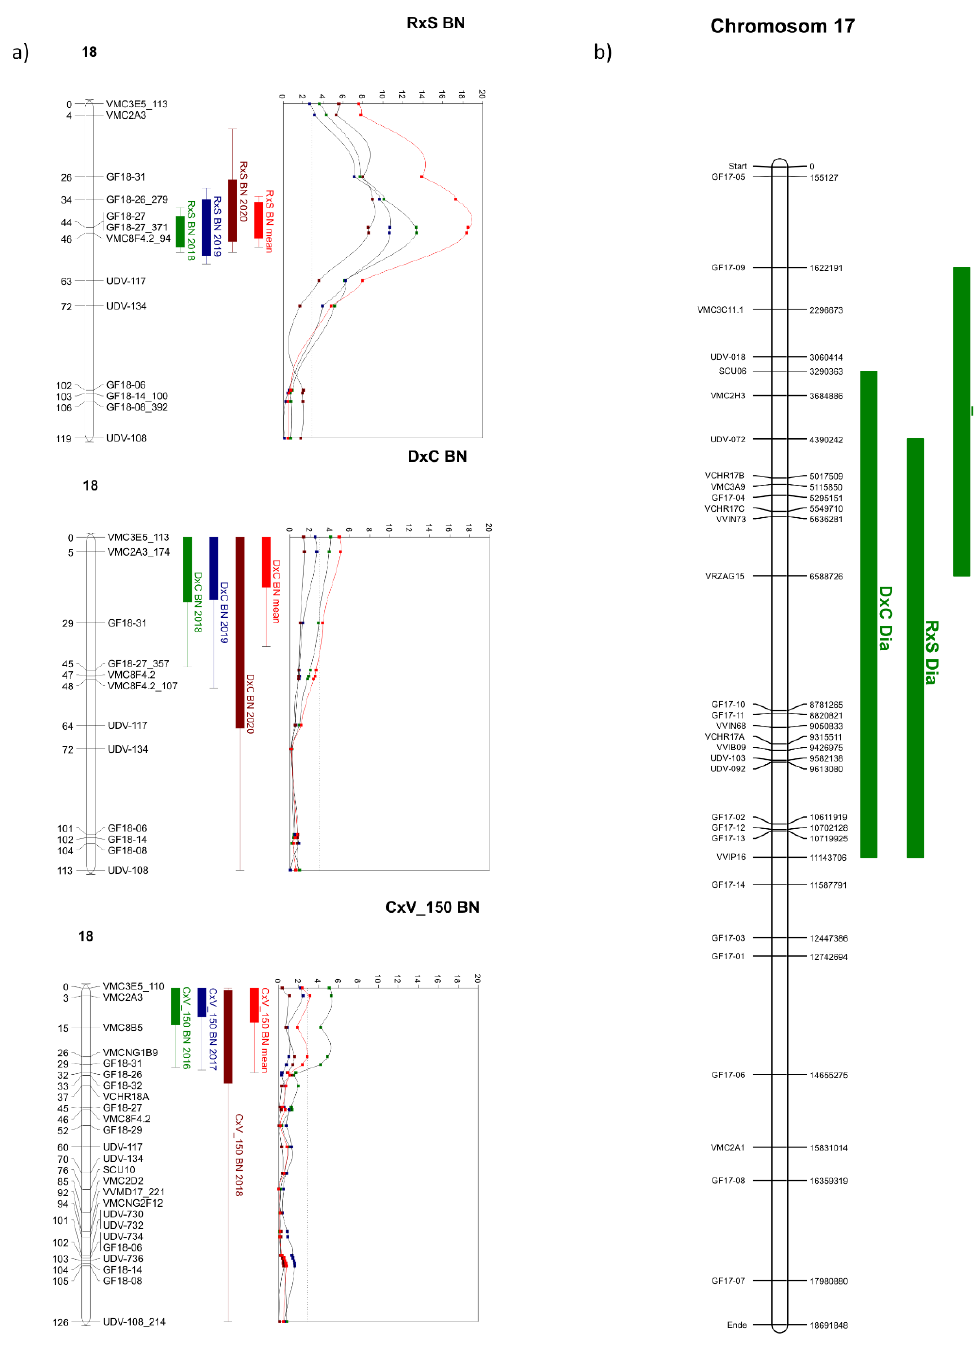
Figure 4. Positions and LODmax of (preliminary) QTLs for the trait BN in different mapping populations. ( a ) and physical position of the trait Dia based on the reference genome PN40024 12X.v2 ( b ). ( a ) Genetic maps of chromosome 18 from the populations R × S, D × C, and C × V_150 with the respective LOD profiles for the QTLof the trait BN. BN—berry number; colored boxes—LOD profiles for the respective seasons (green—2016; blue—2017; purple—2018; and red—mean); and dashed line—LOD specific threshold. ( b ) Physical position of QTLs (Dia) from investigated populations: shown is the genomic region on chromosome 17 with the approximated position of the QTLs for the trait Dia based on the reference genome PN40024 12X v2. Boxes show the chromosome specific confidence interval limited range on chromosome 17. Dia—mean berry diameter (b).